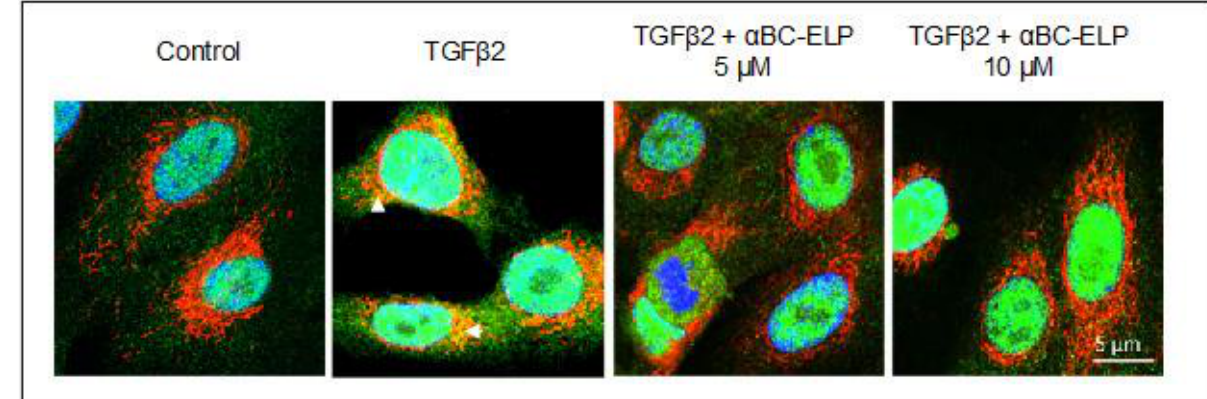
Figure 4. Effect of TGFβ2 on SMAD4 mitochondrial translocation and inhibition by α BC-ELP. hRPE cells were treated with TGF β 2 (10 ng/mL) for 24 h and double stained for mitochondria (Red) and SMAD4 (Green). SMAD4 mitochondrial translocation was observed in TGF β 2 treated cells (white arrow heads) which was inhibited by α BC-ELP at two different doses. Scale bar : 5 µm, Green: SMAD4, Red: Mitotracker, Blue, DAPI.